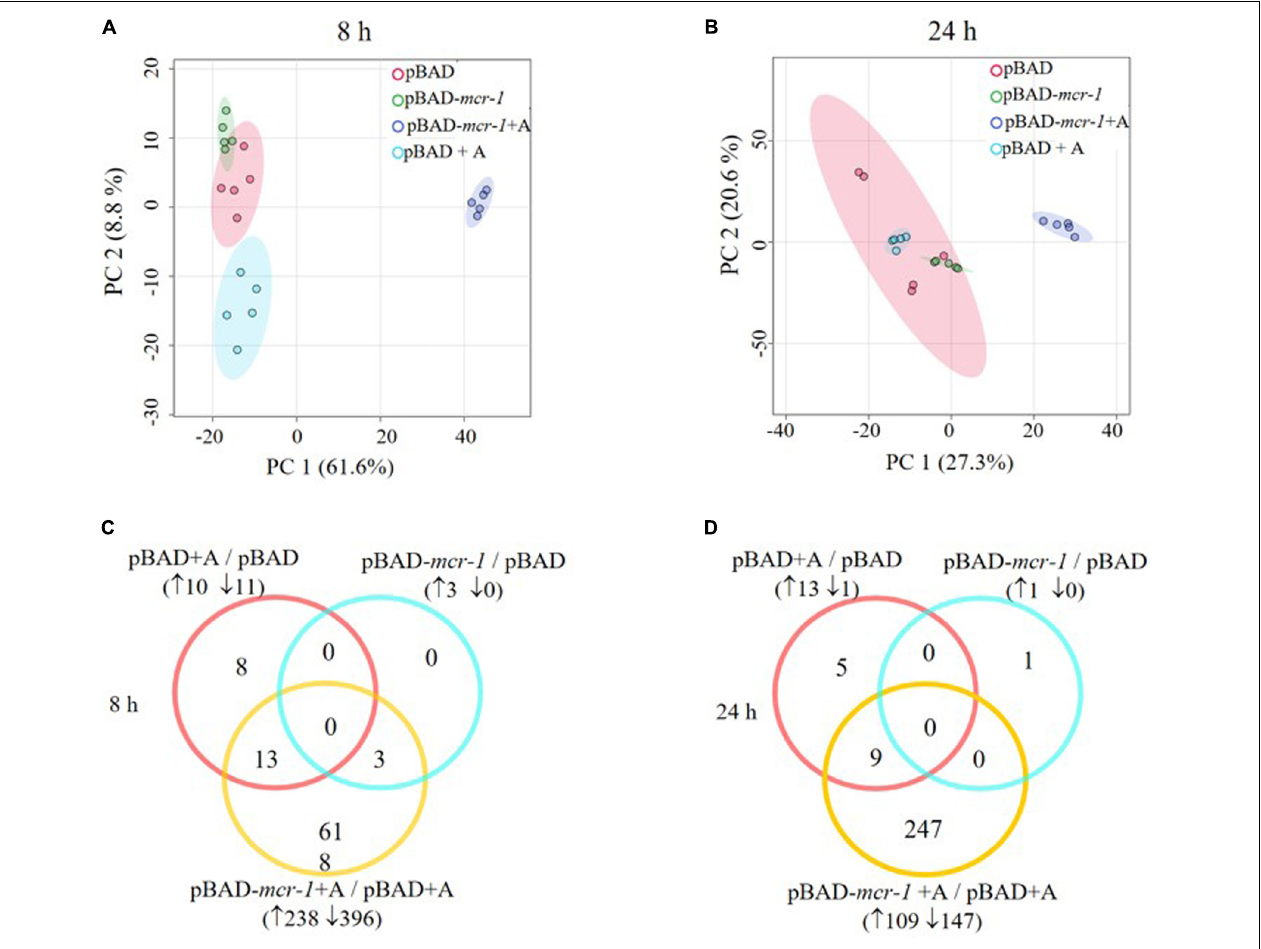
FIGURE 3 | Multivariate and univariate analyses of global metabolic changes. PCA score plots of the first two principle components for metabolite levels from samples ( E. coli TOP10 carrying different recombinant plasmids) with or without 0.2% Arabinose induction at (A) 8 h and (B) 24 h. Each dataset represents a total of 30 samples of 5 biological replicates of each condition. Empty vector pBAD without induction = Red (pBAD), with induction = Blue (pBAD + A); pBAD- mcr-1 without induction = Purple (pBADm_0), with induction = Yellow (pBADm_A). Venn diagrams display the number of metabolites significantly affected by pBAD- mcr-1 , over-expression of pBAD, or over-expression of pBAD- mcr-1 at (C) 8 h and (D) 24 h, relative to the control group. Significant metabolites were selected with FDR < 0.05, p < 0.05 and fold change ≥ 2 (one-way ANOVA).